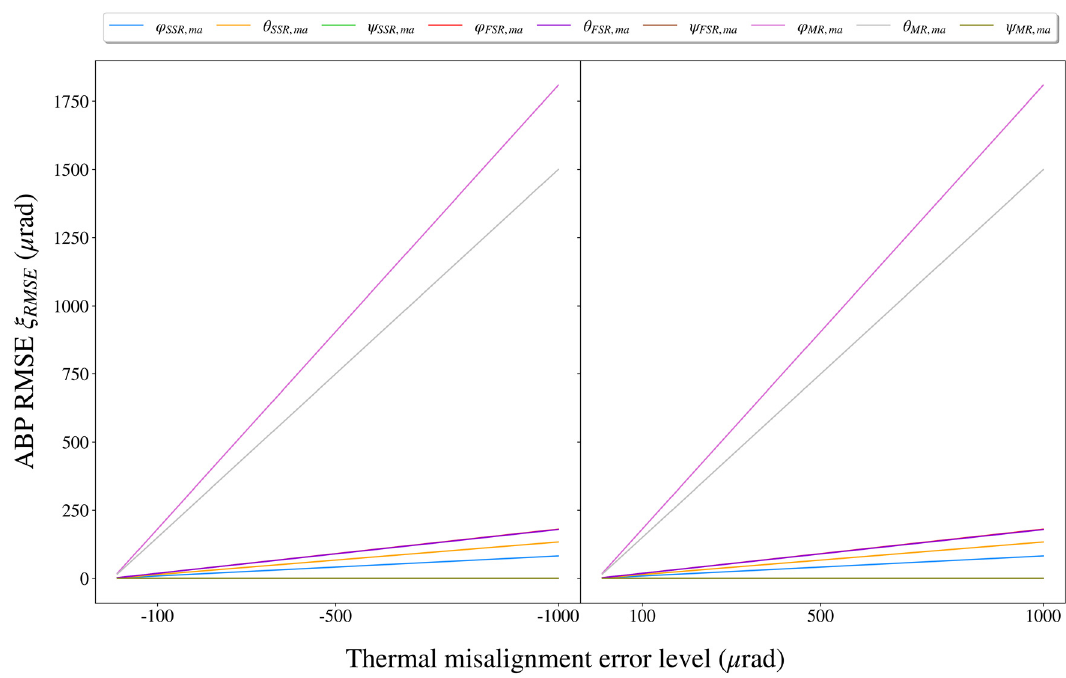
Figure 8. The impacts of different thermal misalignment errors at different levels on the BPE. The impact was measured by the RMSE of the ABPs over a scan period of the ECF. Table 2. The maximum impact of each thermal misalignment error on the BPE at the level of ± 1000 µ rad. Thermal Misalignment